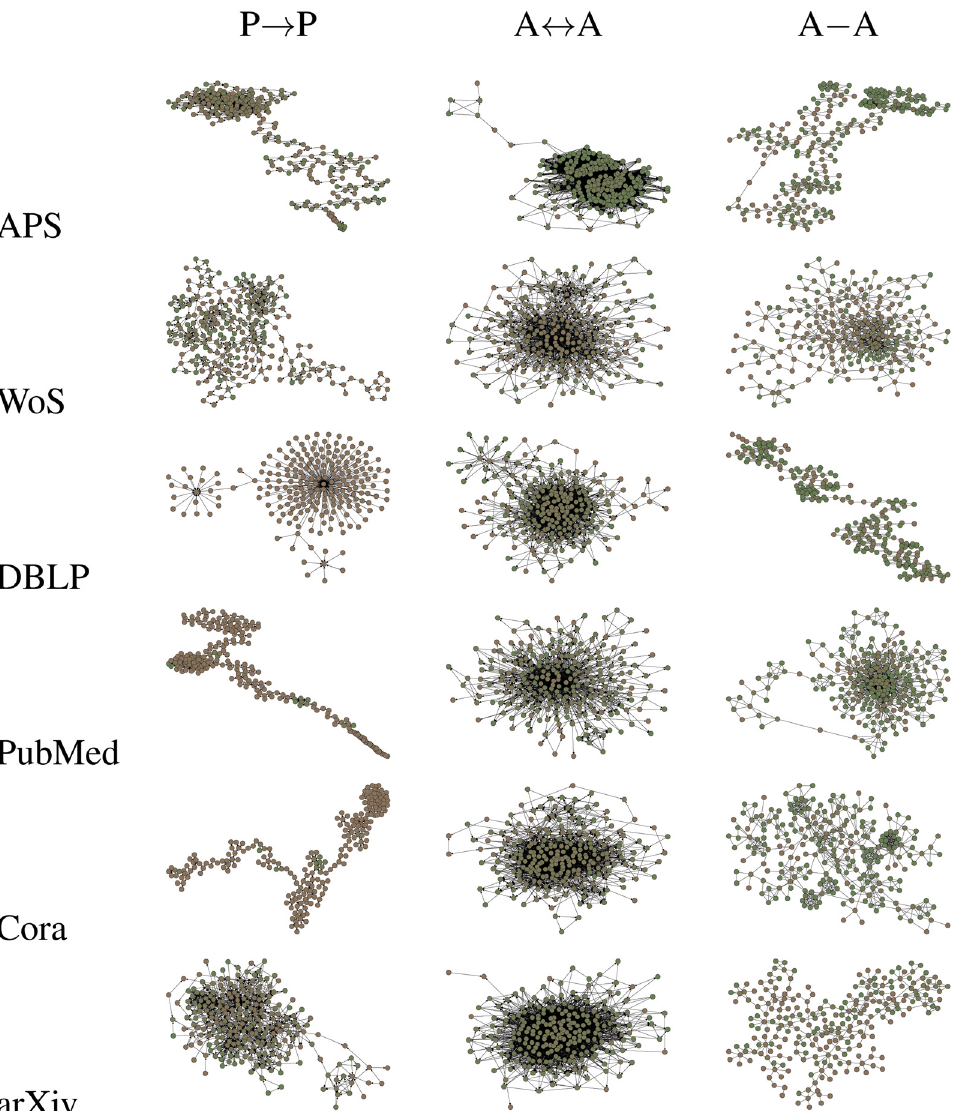
Fig 1. Graphical visualization of the network samples. As indicated, each sample corresponds to one of the 18 examined networks. See Methods for details on network sampling algorithm.